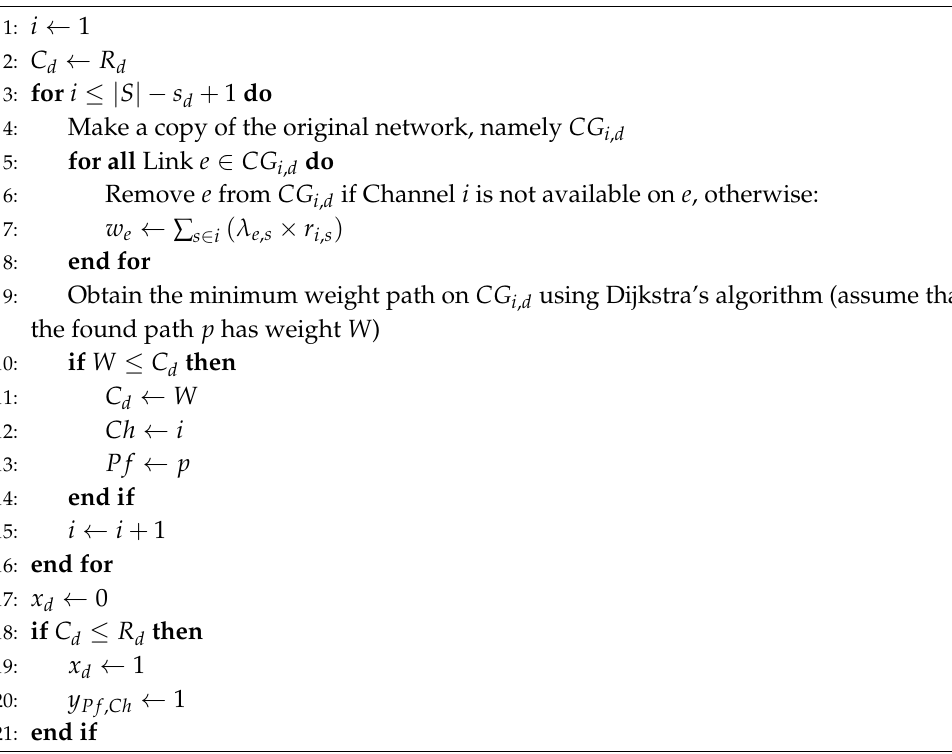
Algorithm 1 Channel-Graph-Based Algorithm for DR Model of Demand d